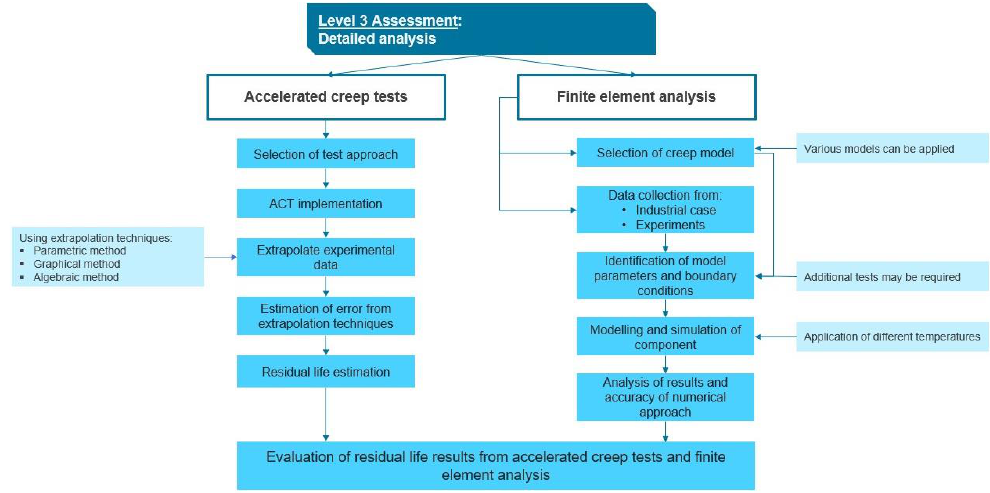
Figure 4. Flow chart on the steps for L3 approach in creep RLA.